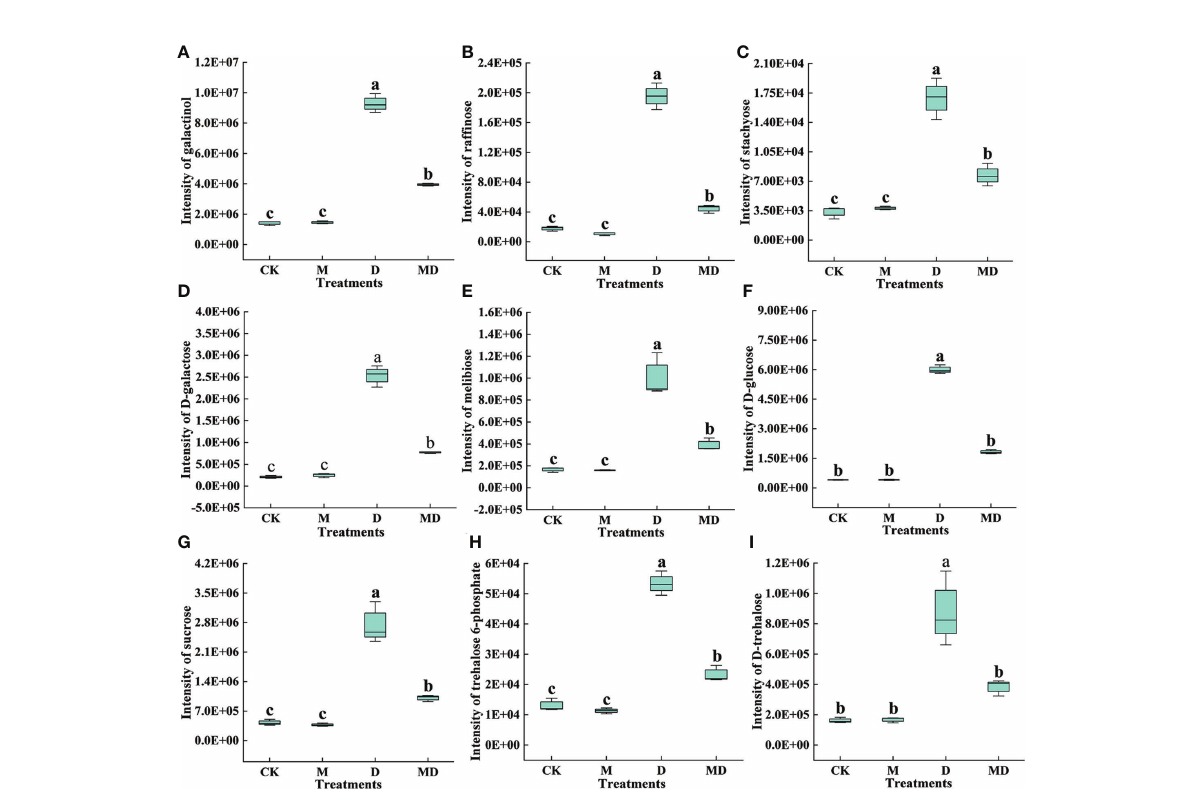
FIGURE 8 Effects of exogenous MT on DEMs in the carbohydrate metabolism pathway in A. mongolicum leaves under drought stress. (A) Galactinol, (B) raf fi nose, (C) stachyose, (D) D-galactose, (E) melibiose, (F) D-glucose, (G) sucrose, (H) trehalose 6-phosphate, (I) D-trehalose. Error bars represent standard errors of triplicate experiments. Mean values with different letters are signi fi cantly different at P < 0.05.